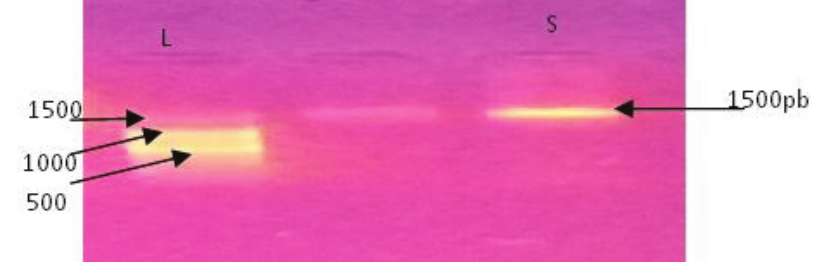
Figure 1: Amplified fragment detection, L: ladder (500 bp), S: Sample 5.